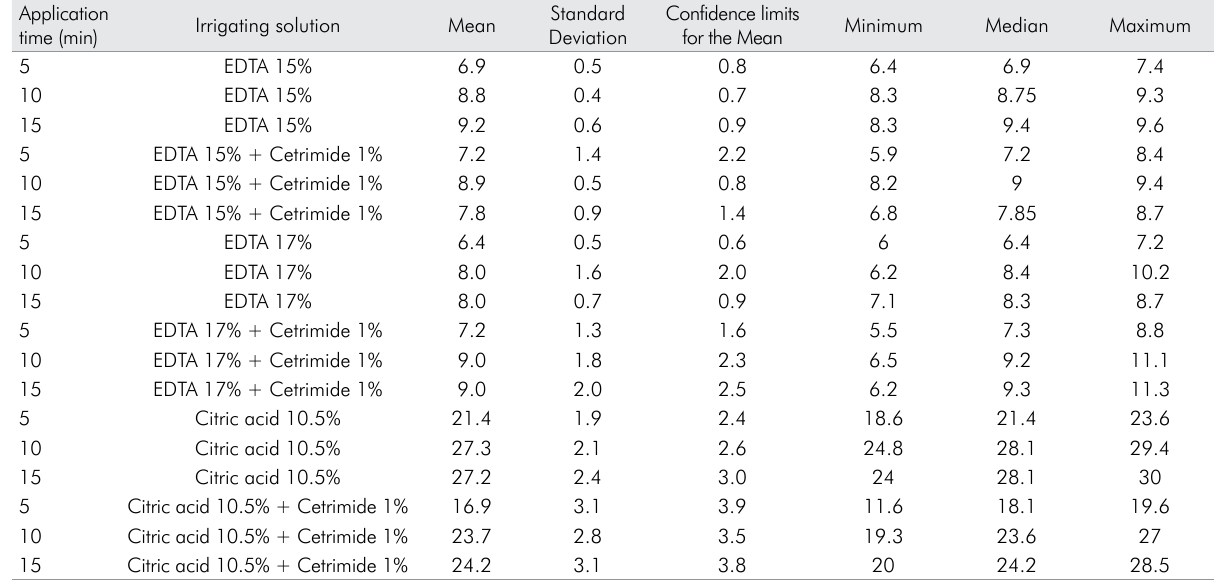
Table 1. Calcium released (mg/l) from root canal dentin after 5, 10, and 15 minutes treatment with tested irrigating solutions. Application time